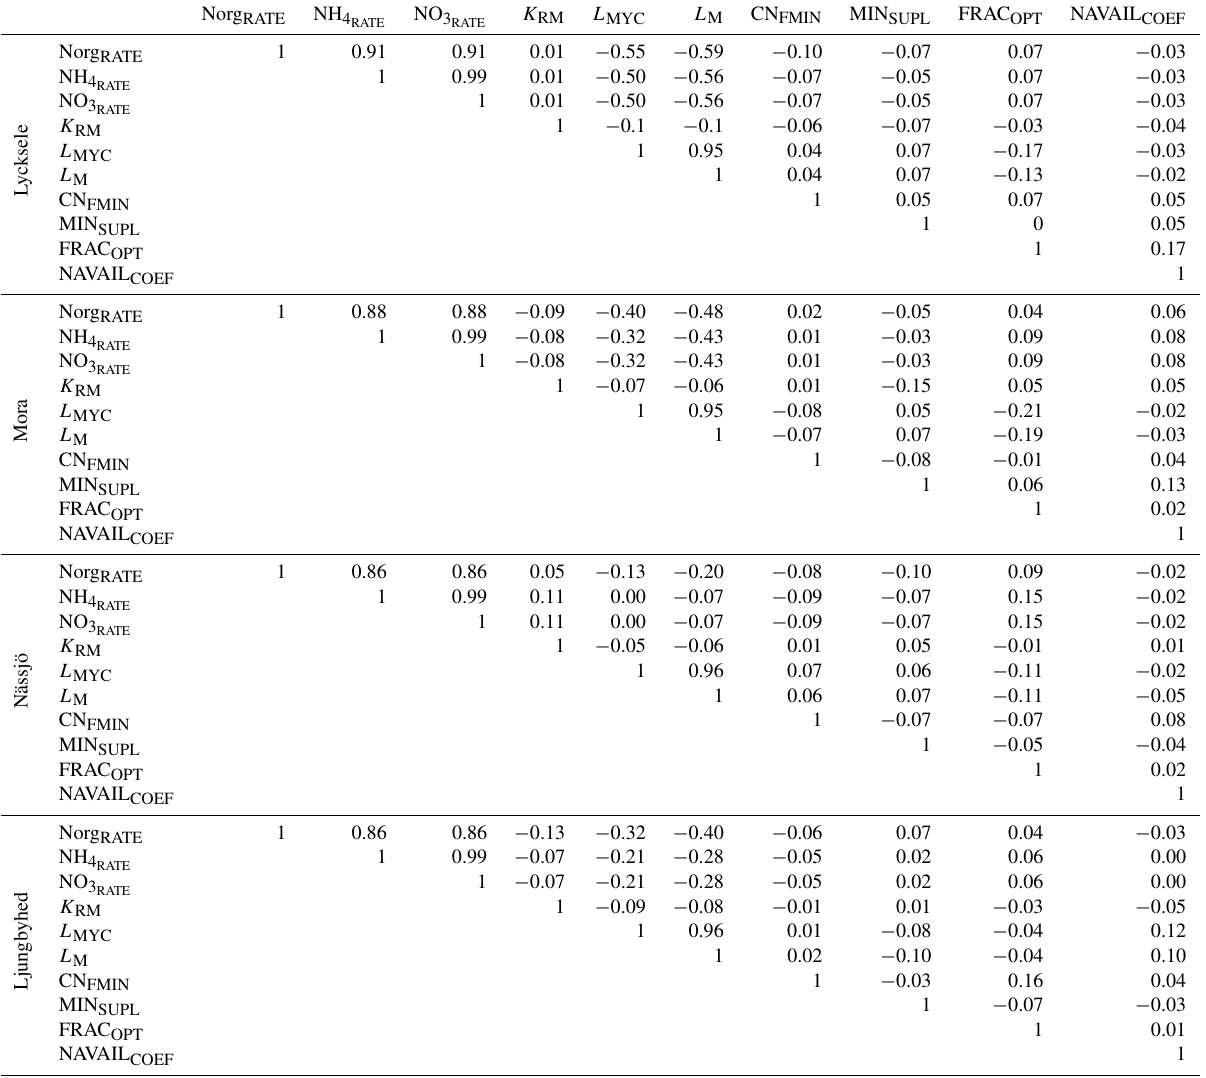
Table A4. Correlation between fungal model parameters with the explicit approach for all sites. Correlation is given as the Pearson correlation